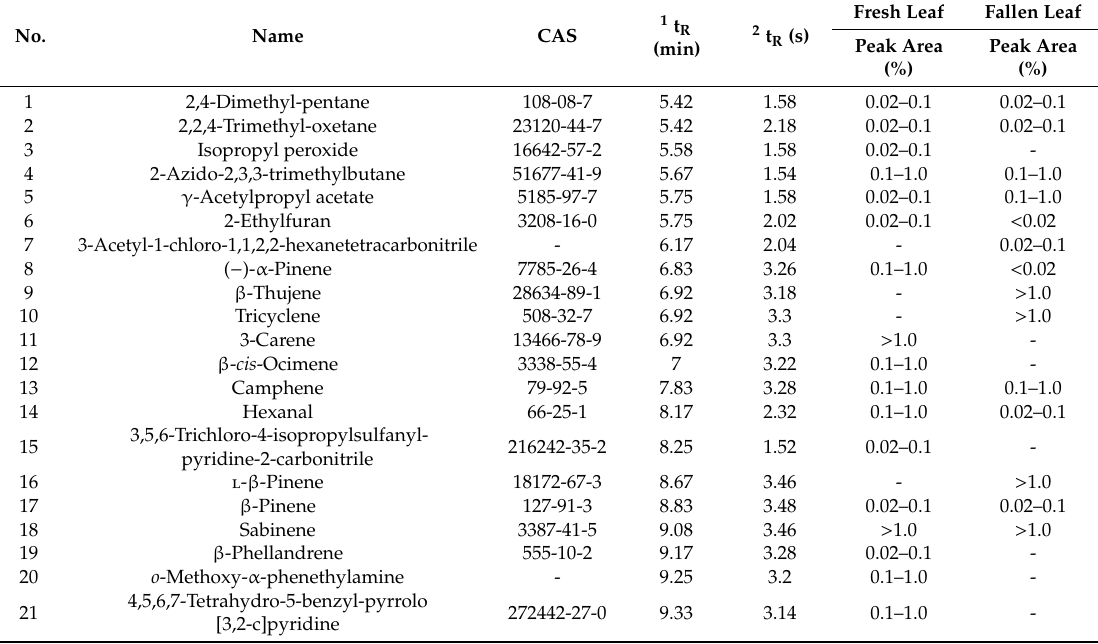
Table 2. Chemical profile identified from the essential oils of C. camphora fresh leaf and fallen